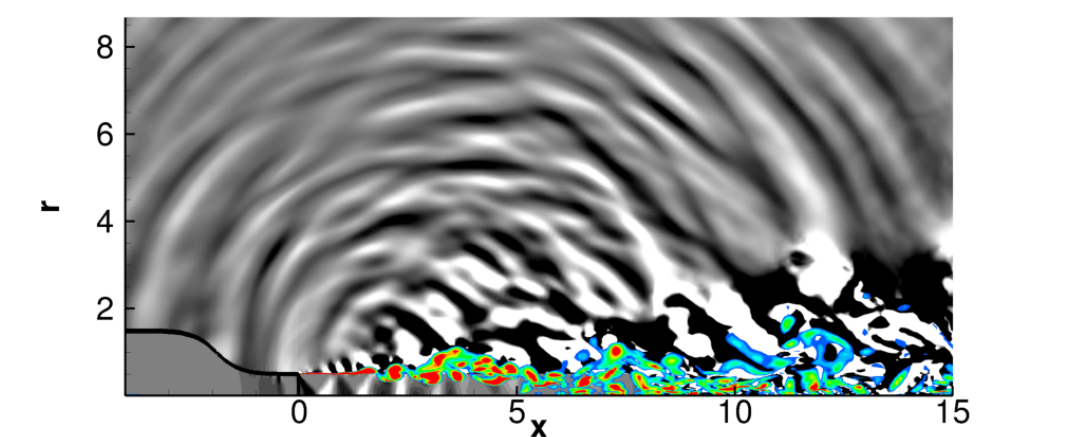
Figure 3. Instantaneous snapshot of the jet. The expansion and compression regions in the potential core are highlighted using u · ∇ p , in the region 0 ≤ r ≤ 0.5 and 0 ≤ x ≤ 8. 10 equally spaced contour levels are used within the range 1 and − 1. The shear layer is shown using magnitude of vorticity, using 11 contour levels between 1.5 and 5, with blue and red representing the minimum and maximum levels, respectively. The acoustic emissions in the nearfield are visualized using divergence of velocity, using 10 contour levels between − 0.01 and 0.01. The jet-flow direction is from left to right. The outline of the nozzle is marked with the black line. The color contours of vorticity